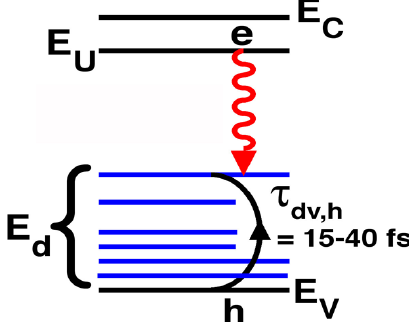
Figure 10 . This is an ideal optical material [7]: the four-level system has a large radiative output, and exhibits fast depopulation of electrons from the lower state of the optical